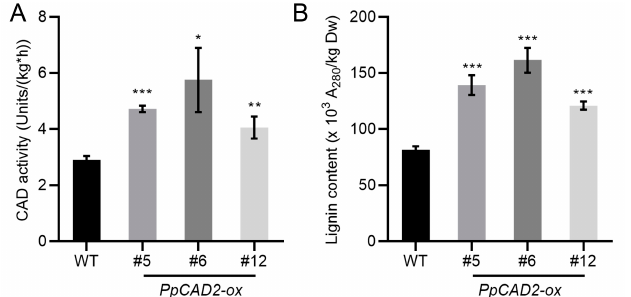
Figure 3. PpCAD2 increases the lignin content and CAD enzyme activity in the fruit pericarp of transgenic tomato plants. ( A ) The lignin content of the fruit pericarp in the WT and transgenic plants; ( B ) The CAD enzyme activity in the fruit pericarp of the WT and transgenic plants. In ( A ) and ( B ), the data represent the mean ± SD (standard deviation) from three biological replicates. Significant differences between the wild-type and transgenic plants are indicated (* P < 0.05, ** P < 0.01, *** P < 0.001, Student’s t-test ).